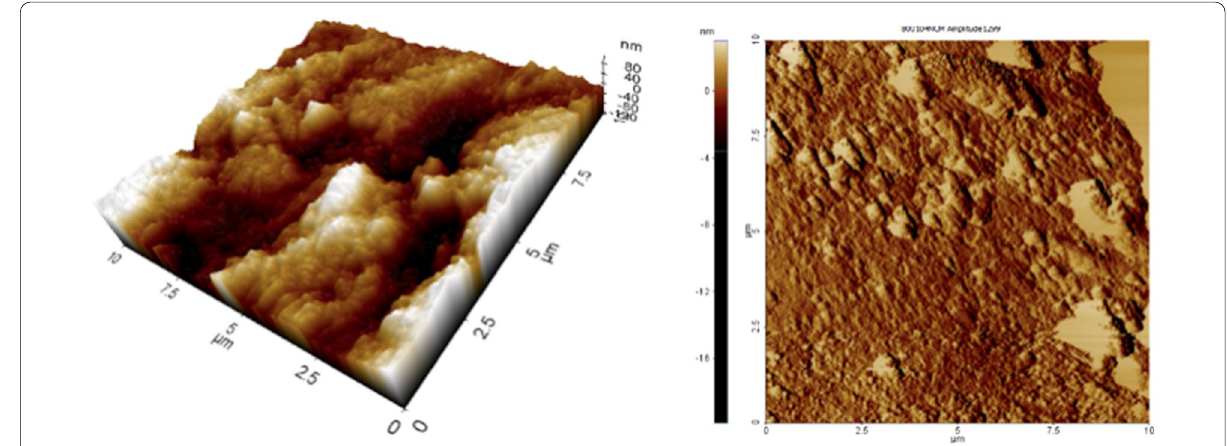
Table 1 Means, standard deviation, and t test results of surface roughness measurements (nm nano meters) for both groups =